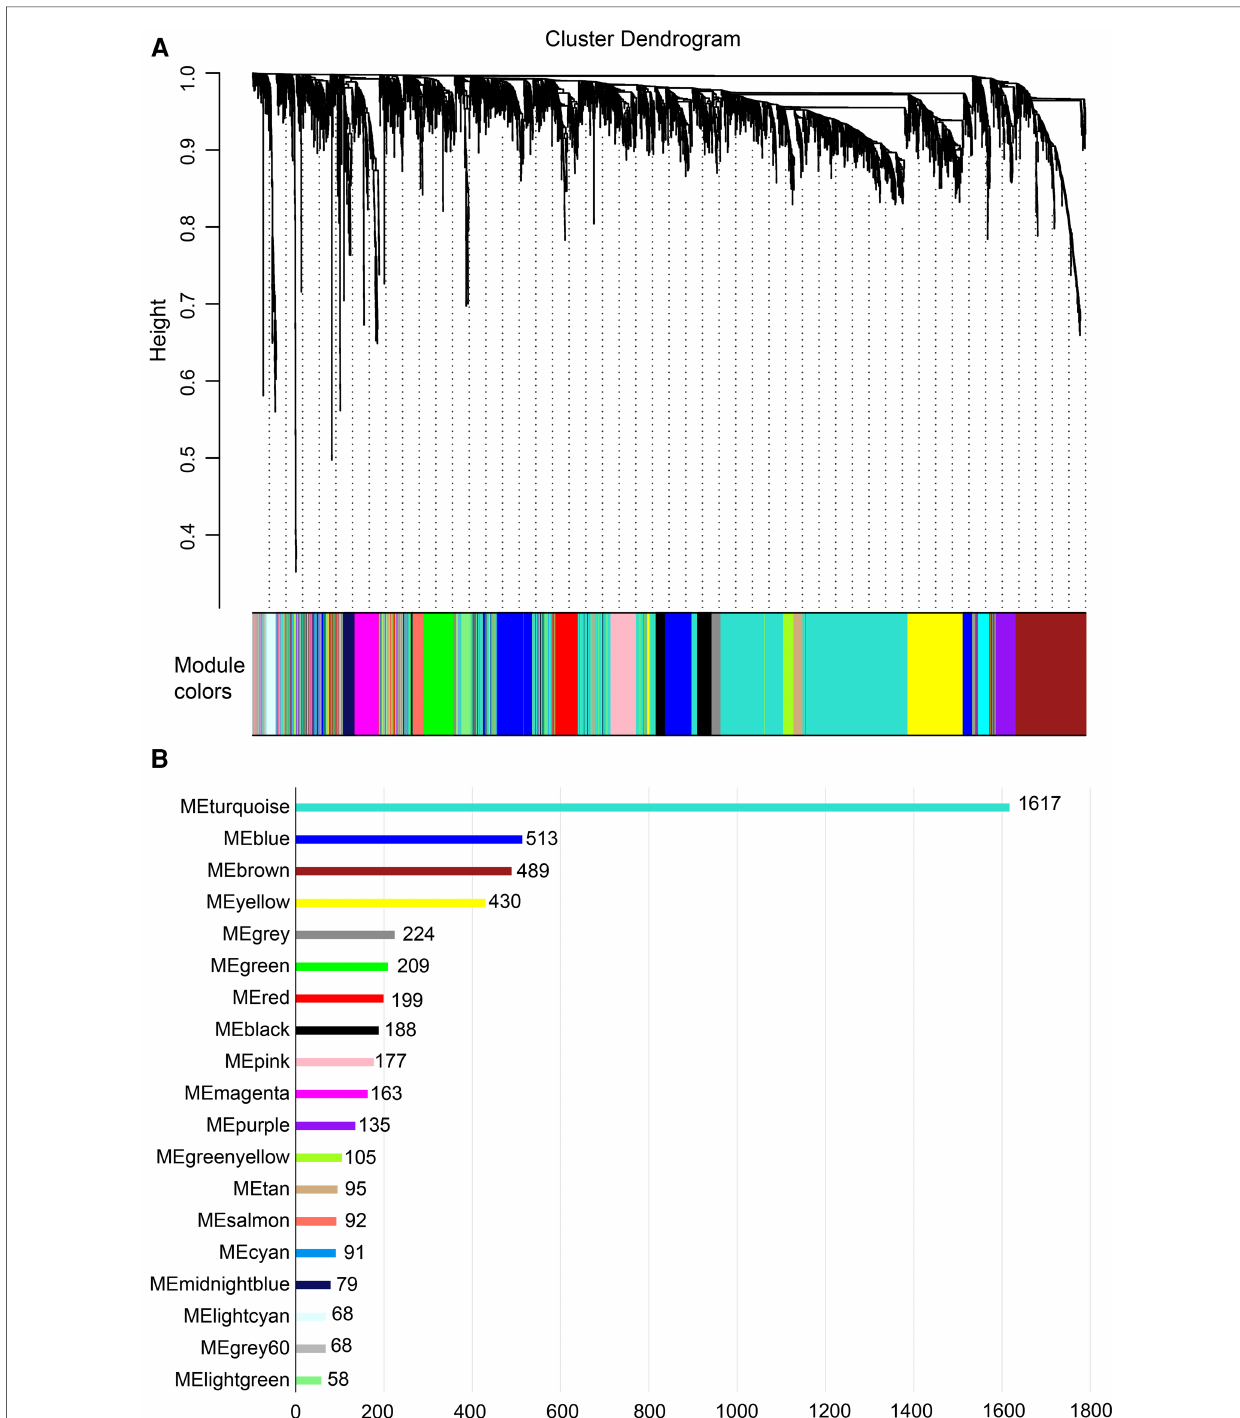
FIGURE 3 Construction of co-expression network. ( A ) Nineteen co-expression modules constructed by clustering dendrograms and partitioned into different module colors (non-clustering genes shown in gray). ( B ) The bar plot of numbers in